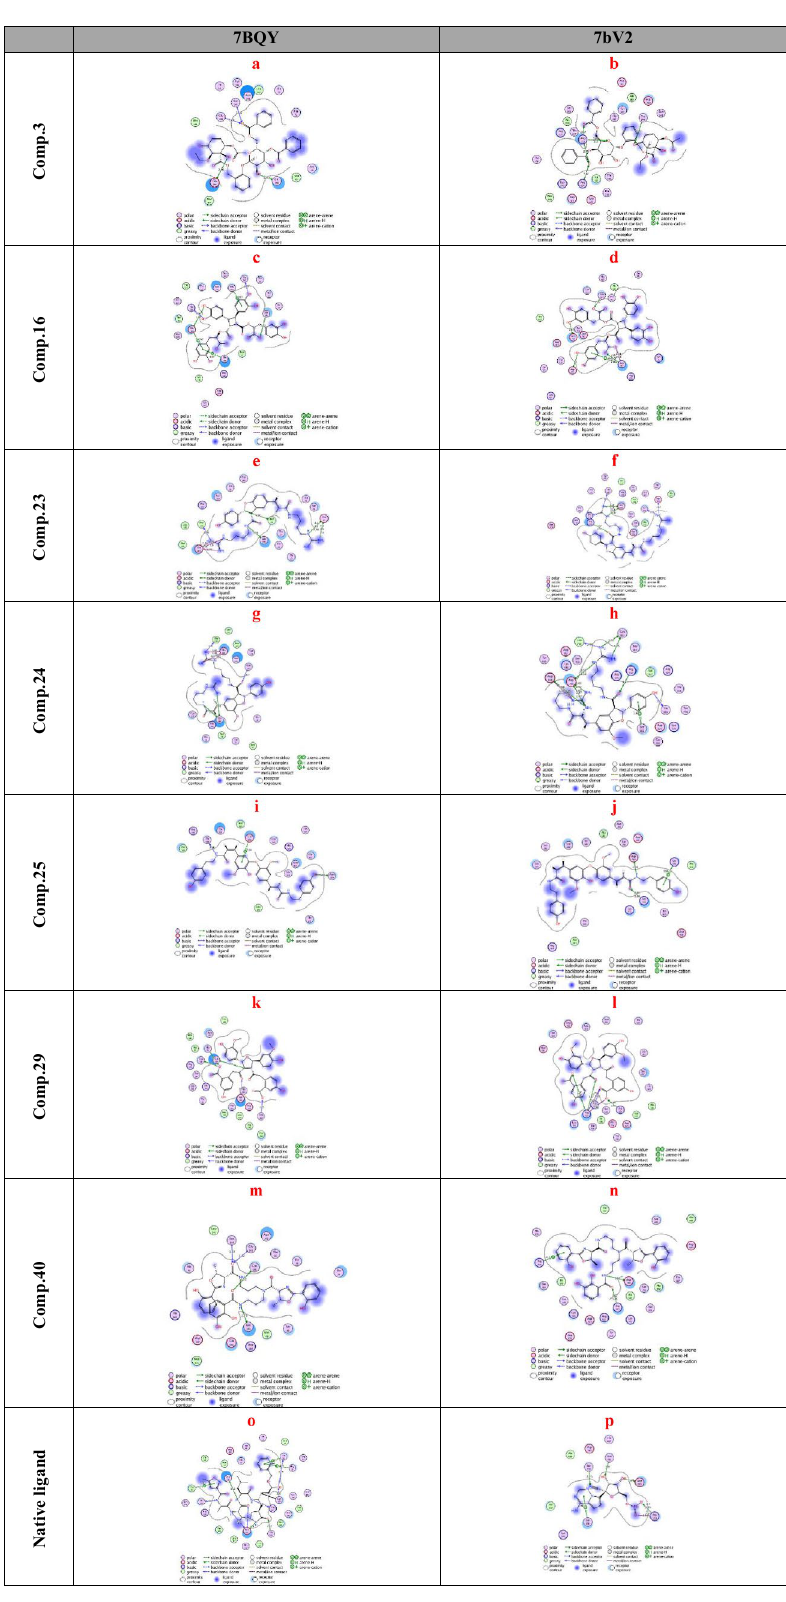
Fig. 4 Best Molecular docking patterns of candidate com- pounds 3 , 16 , 23 , 24 , 25 , 29 , 40 and native ligands into 7BQY and 7bV2